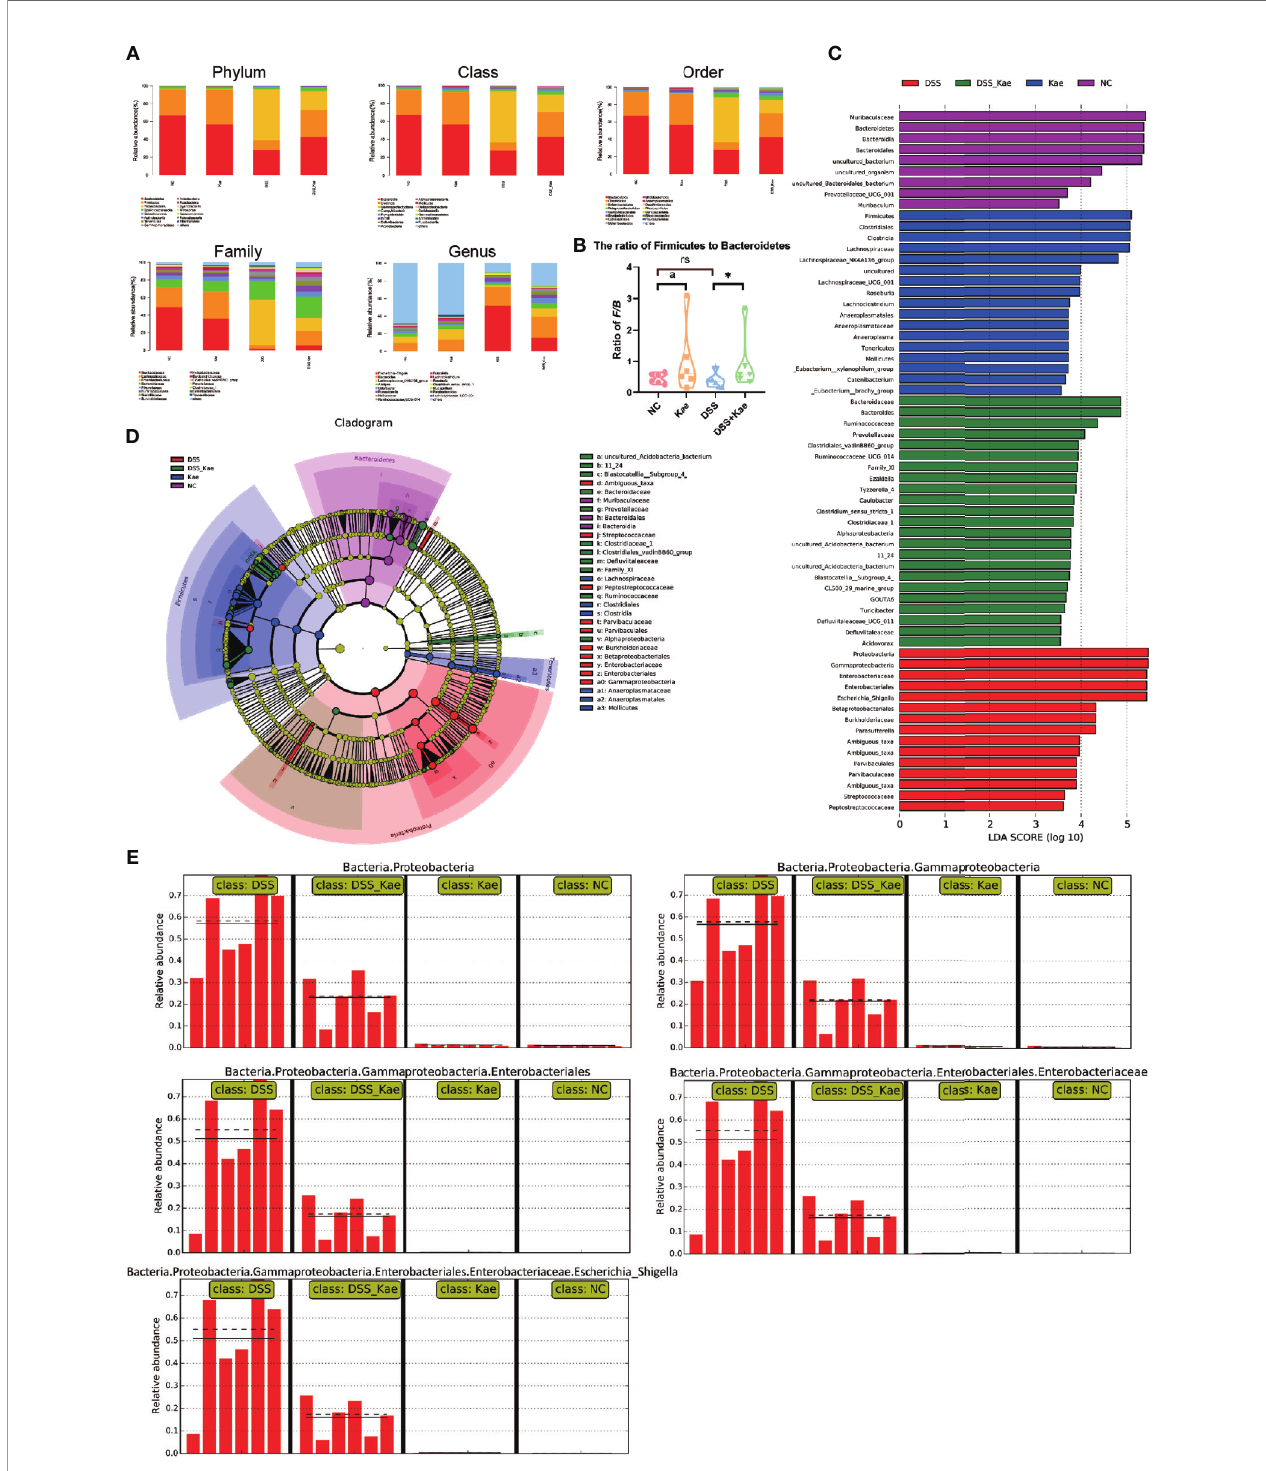
FIGURE 5 | (A) Taxonomic analysis of microbiota in fecal samples at the phylum, class, order, family, and genus levels. (B) Ratio of Firmicutes to Bacteroidetes in the gut microbiota. (C) LDA scores for bacterial taxa signi fi cantly enriched in gut microbiota from each group (LDA score > 3). (D) Cladogram illustrating the results of LEfSe analysis. (E) All-against-all algorithm of LDA coupled with LEfSe. Ratios are expressed as the mean ± SEM, n = 6, analyzed using one-way ANOVA with Tukey post-hoc analysis. DSS ( vs . DSS-Kae, * P < 0.05); Kae ( vs. NC, a P < 0.05); ns, no signi fi cant difference. The signi fi cance of differences in taxonomic groups were assessed using the non-parametric factorial Kruskal-Wallis sum-rank test, n = 6. P < 0.05 was considered to indicate a signi fi cant difference between